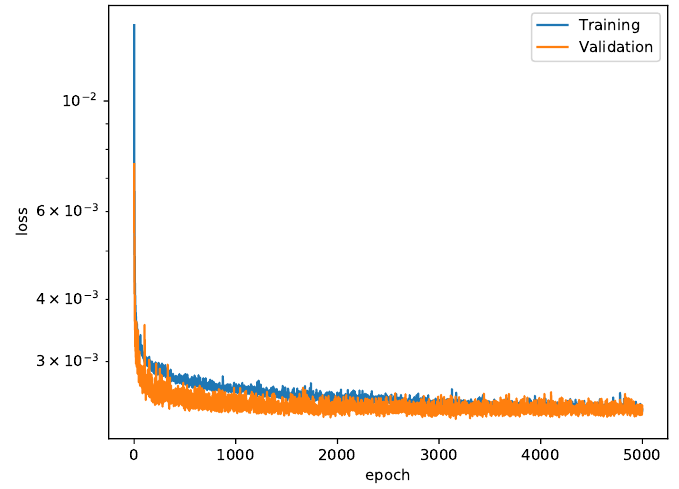
Figure 22. The training and validation loss curves for the 3D-truncated icosahedron tensegrity. Figure 23 shows rectangular coordinates of the truncated icosahedron tensegrity in a 2 × 2 × 2 cube. The 2 × 2 × 2 cube is located in the 3D rectangular coordinate system so that the eight vertices occupy the position at ( ± 1, ± 1, ± 1). In geometry, the truncated icosa- hedron tensegrity has 12 regular pentagonal faces, 20 regular hexagonal faces, 60 vertices and 90 edges. The truncated icosahedron tensegrity can be decomposed into 20 hexagonal pyramids and 12 pentagonal pyramids by drawing segments from all the vertices of the truncated icosahedron tensegrity toward the origin [45]. The analytical expression and numerical values of pin-joints of the truncated icosahedron tensegrity module are given √ √ √ in Table 7, where a = ( 3 + 5 ) /6, b = ( 5 − 1 ) /3, and c = 5/3. Here, the notation b indicates the edge length of the pentagonal